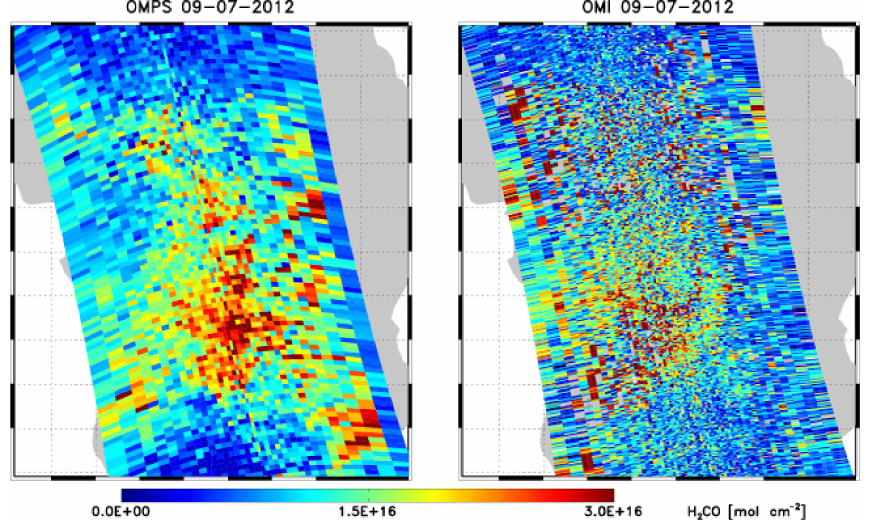
Figure 6. Africa overpass H 2 CO retrieval on 9 September 2012 for OMPS (left panel) and OMI (right panel) illustrating the difference in pixel size between both instruments. Since 2008 OMI orbits have been affected by the row anomaly. We have not filtered out OMI pixels affected by